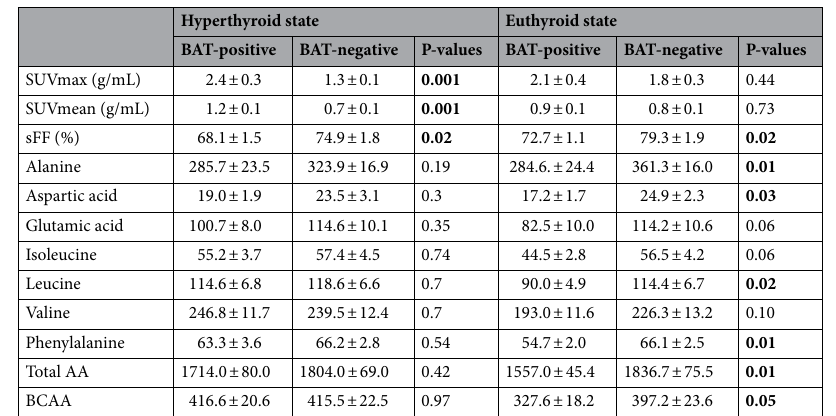
Table 3. Comparison amino acids profile between BAT-positive and BAT-negative participants before and after treatment. N = 21. BAT-positive n = 8, BAT-negative n = 13. Data presented as mean ± SEM. P values represents Independent Sample’s t -test between BAT-positive and BAT-negative subjects. Statistically significant values are shown in bold. SUVmax standardized uptake value maximum, SUVmean standardized uptake mean value, sFF supraclavicular fat fraction, AA amino acids, BCAA branched-chain amino acids (isoleucine, leucine and valine).